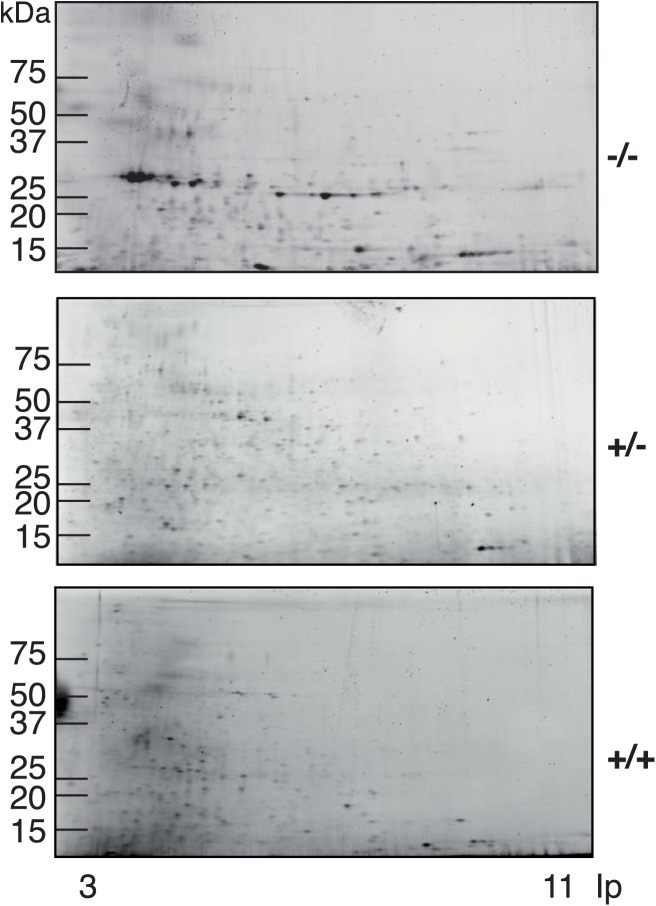
Two-dimensional electrophoresis of fecal protein samples of Galphai2-/- mice, Galphai2+/- mice, and wild-type littermates.Samples were run on gels with broad coverage of isoelectric points (3‒11) and molecular weights. A few spots of high intensity, that markedly differed from their heterozygous and wild-type littermates, predominated in the gels from Galphai2-/- mice.